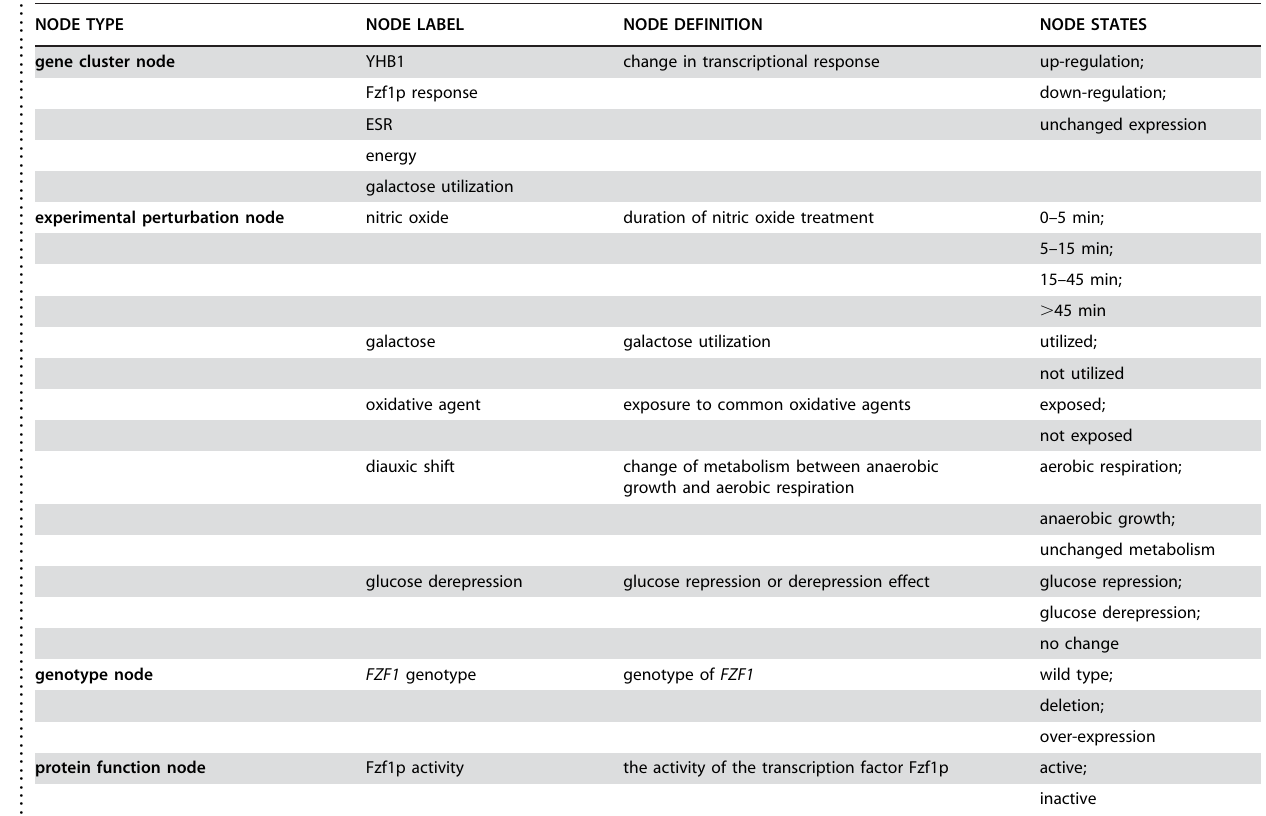
Table 3. Network nodes defined in the third nitric oxide response model. .. ... .... ... ... .... ... ... .... ... ... .... ... ... .... ... ... .... ... ... .... ... ... .... ... ... .... ... ... .... ... ... .... ... ... .... ... ... .... ... ... .... ... ... . NODE